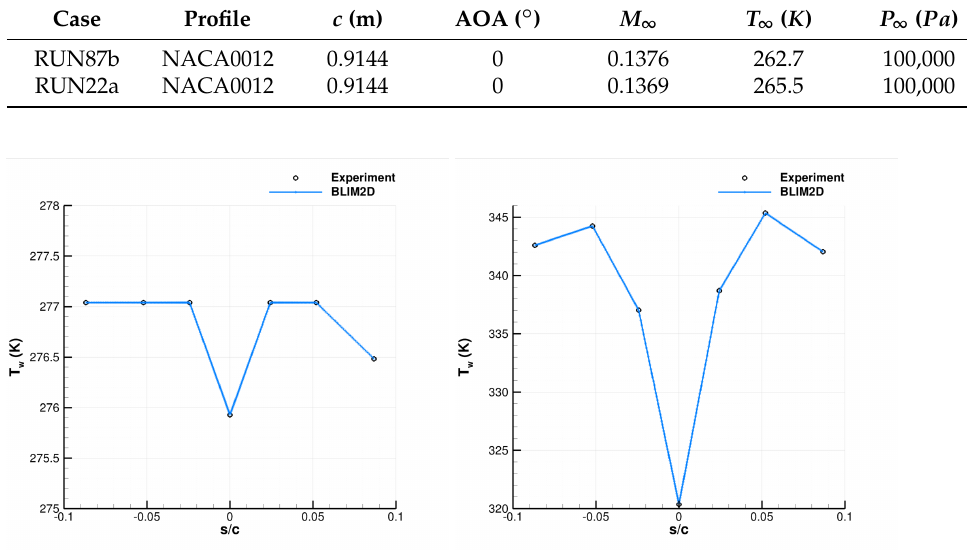
Table 1. Test cases from Al-Khalil’s database for the analysis of the boundary-layer solvers.